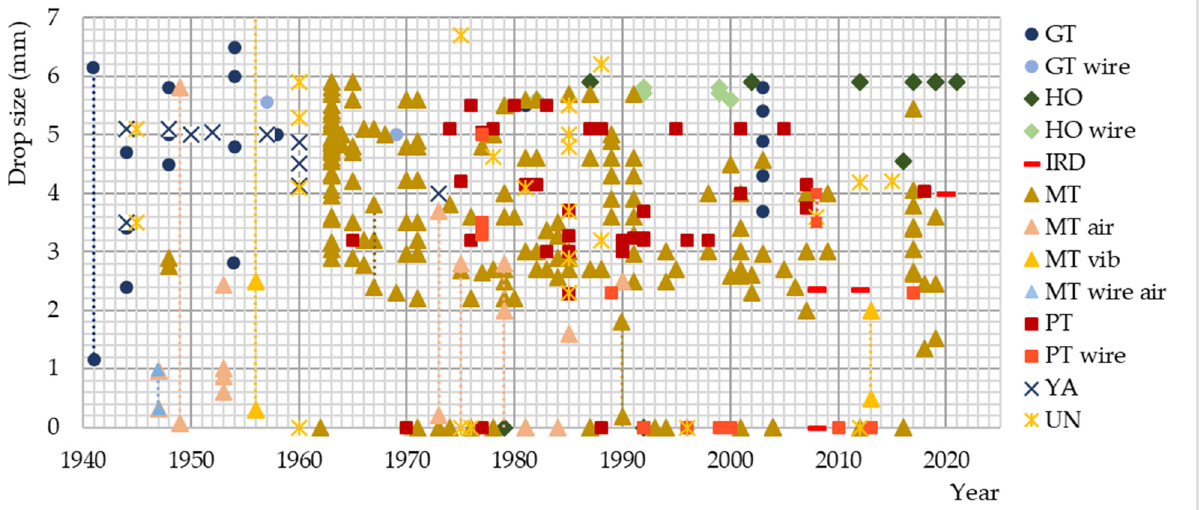
Figure 7. Type and subtype (modified performance drippers) of drippers and corresponding sizes of generated drops used in previous rainfall simulations (GT—glass tubes, GT wire—glass tubes with threads, HO—holes in dripper reservoir, HO wire—holes in dripper reservoir with threads, IRD—irrigation drippers, MT—metal tubes, MT air—metal tubes under the influence of air flow, MT vib—metal tubes under the influence of vibration, MT wire air—metal tubes with threads under the influence of air flow, PT—plastic tubes, PT wire—plastic tubes with threads, YA—hanging yarn and UN—unspecified dripper type). Note: for markers located on a horizontal line with a value of 0, the diameter of the generated drops was not specified [32]. Also, dotted lines represent simulated drop diameter values that are given in a range.